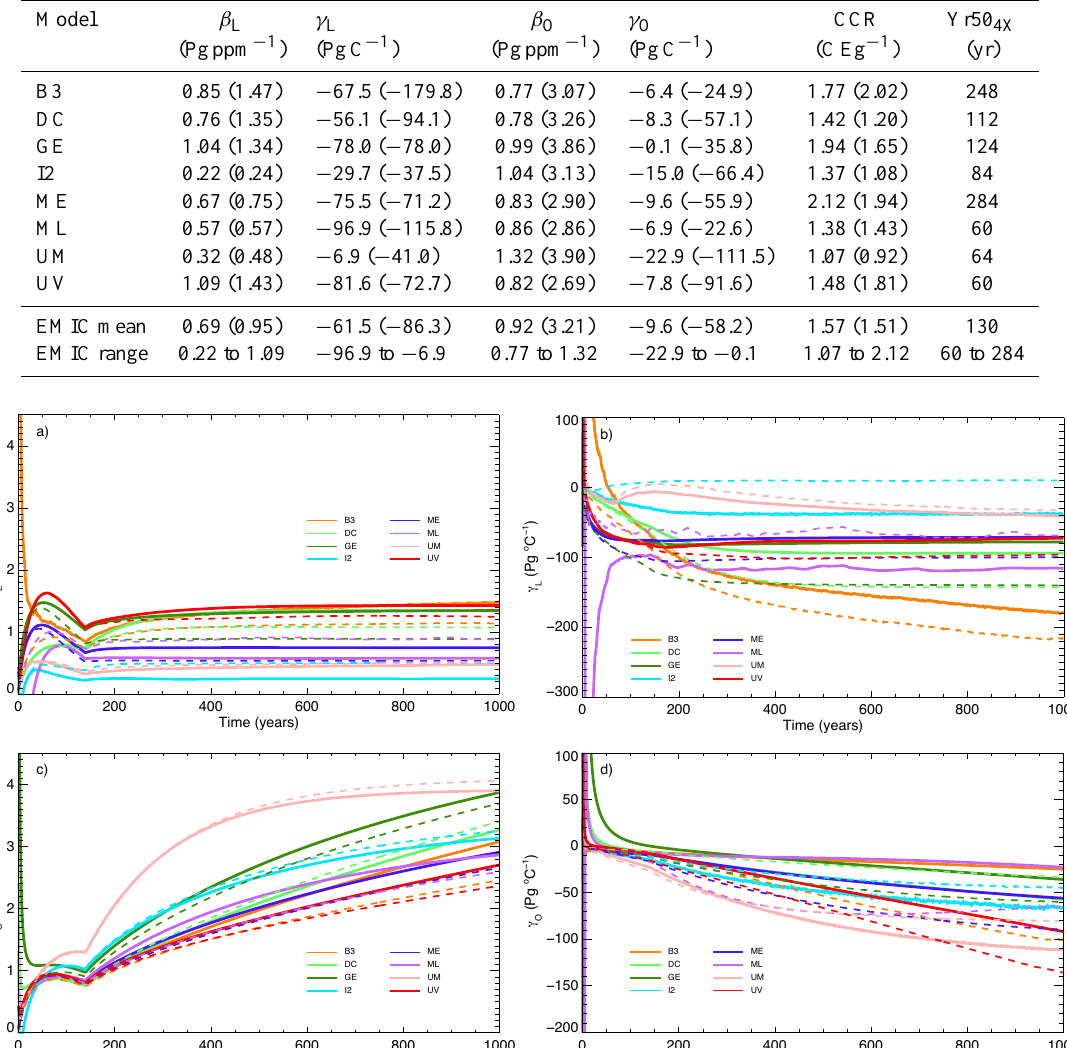
Table 4. Carbon cycle sensitivities and metrics from idealized 4 × CO 2 experiments. β L (or β O ) is the change in land (or ocean) carbon divided by the change in atmospheric CO 2 in a radiatively uncoupled simulation. γ L (or γ O ) is the change in land (or ocean) carbon divided by the change in atmospheric temperature, in a biogeochemically uncoupled simulation. CCR is the carbon-climate response and is calculated as atmospheric temperature change divided by diagnosed emissions (Matthews et al., 2009). β L , γ L , β O , γ O , and CCR are all averages over the decade centred at about year 140 from a 1% increase to 4 × CO 2 experiment. Numbers in parentheses are averages over the decade centred at year 995. Yr50 4X is the year that emissions remaining in the atmosphere fall below 50%, from an instantaneous 4 × CO 2 pulse experiment.